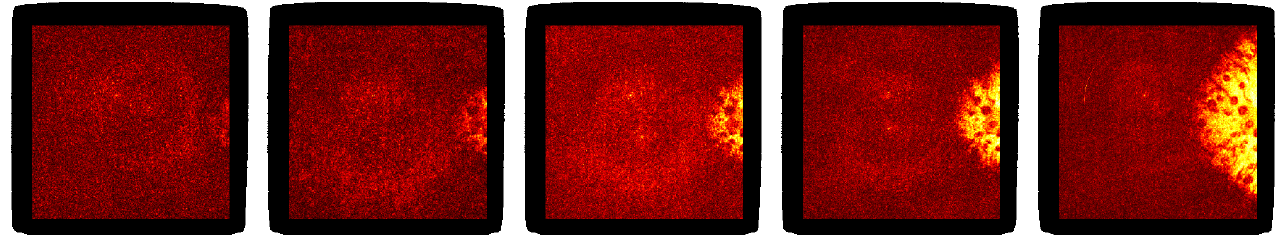
Figure 1: Surface crack evolution at 160 kc, 175 kc, 190 kc, 205 kc and 240 kc obtained from DVC residuals (the cross section of the sample is 1.5x1.5 mm 2